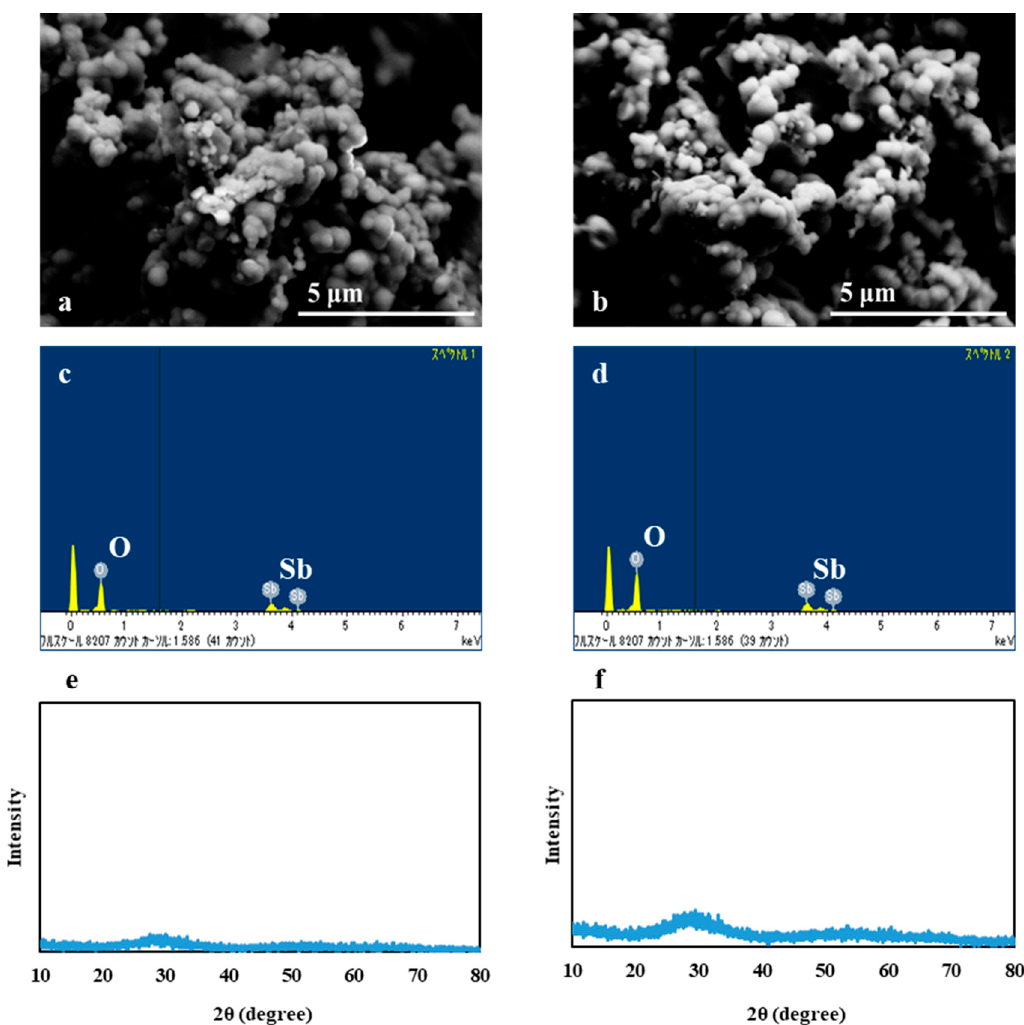
Figure 3. Scanning electron micrographs ( a , b ), energy-dispersive X-ray spectroscopy spectra ( c , d ), and X-ray diffraction patterns ( e , f ) of precipitates formed during anaerobic Sb(V) reduction for 7 d by strains AR-2 ( a , c , e , respectively) and AR-3 ( b , d , f , respectively). Table 2. Elemental distribution in precipitates formed through anaerobic Sb(V) reduction by strains AR-2 and AR-3.